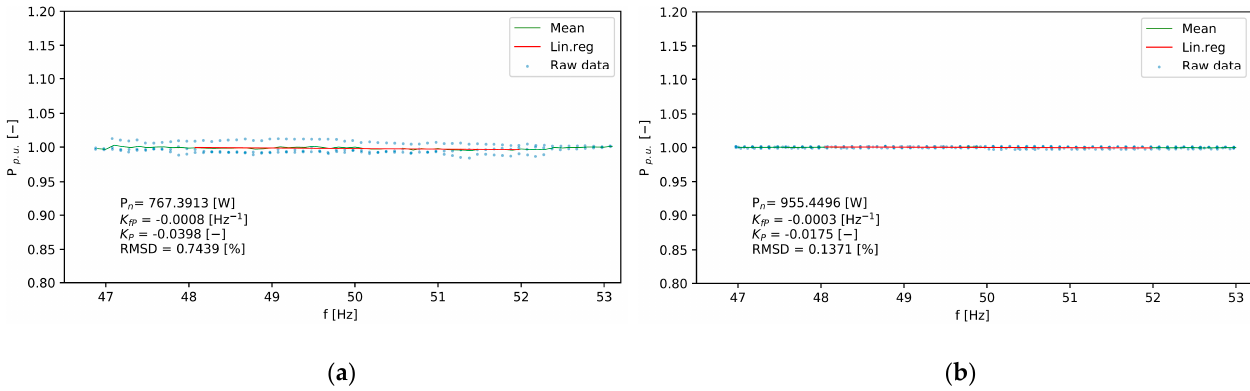
Figure 4. Example of the analyzed result of static load characteristic of ( a ) vacuum cleaner (800 W); ( b ) and heat gun (2000 W) operated at half power .